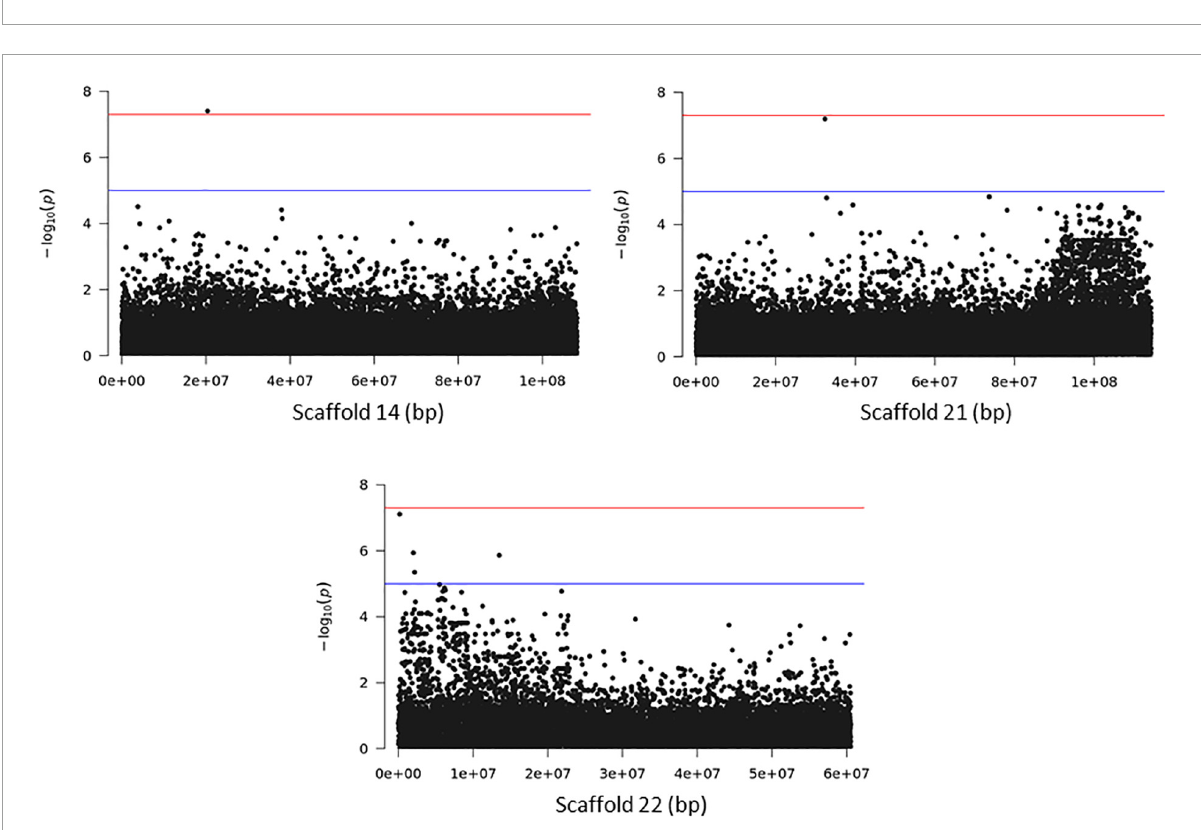
FIGURE9 Genome Wide Association Analysis on the top part of bamboo. Manhattan plots of scaffolds harboring INDELs with p ≤ 10 − 7 .